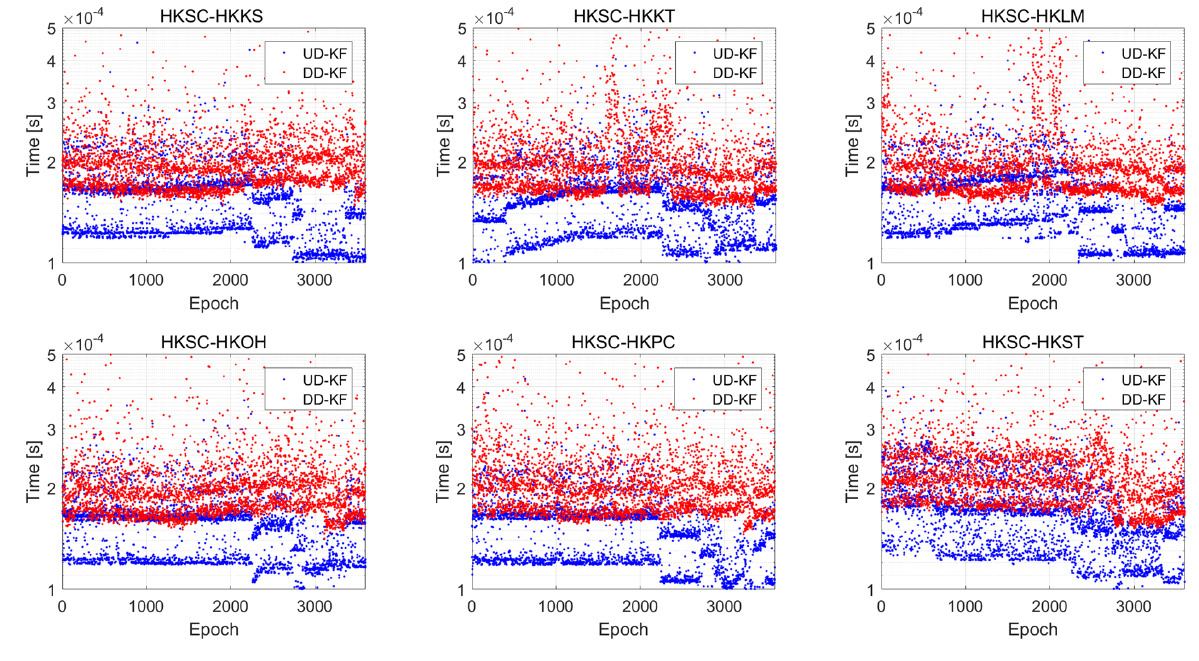
Figure 9. Filter computation efficiency.